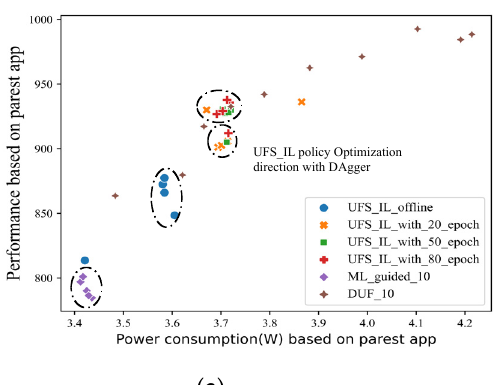
Figure 7. This is the main improvement point of the IL-based UFS policy over other UFS policies that rely on offline training. We implement six policies, four of which are UFS_IL policies at different online learning stages, 0, 20, 50, and 80 bars respectively after fine- tuning the aggregated schematic data. The other two are the ML_guided policy and the DUF policy with a performance degradation index θ of 0.1. A larger θ implies a larger uncore frequency tuning range.